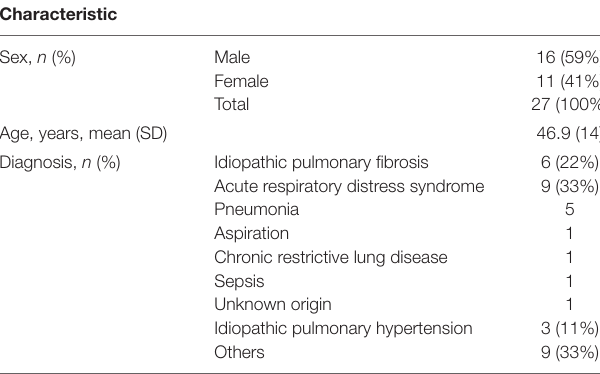
TablE 1 | Patient demographics.